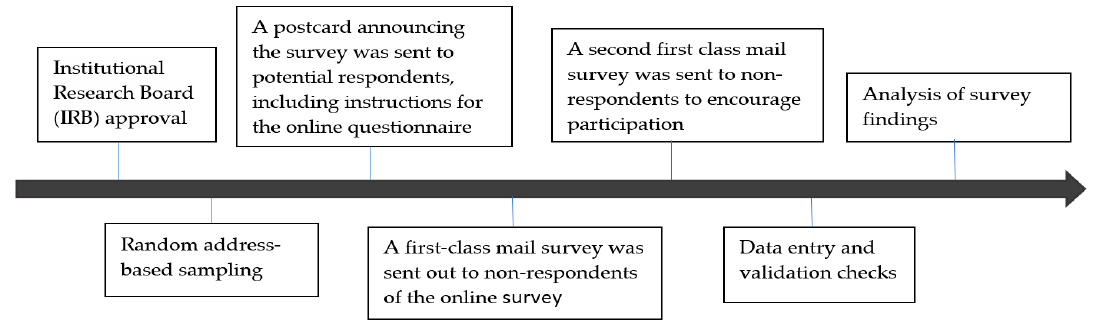
Figure 1. Survey Figure 1. Survey implementation.